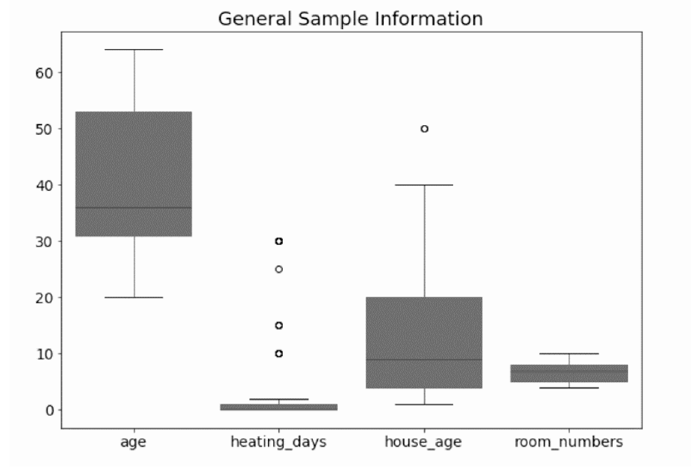
Figure 1. General information of the selected sample. The figure shows box plots of the information gathered during the fieldwork stage from the sample. The black line within the box represents the mean. The circles represent the outliers.